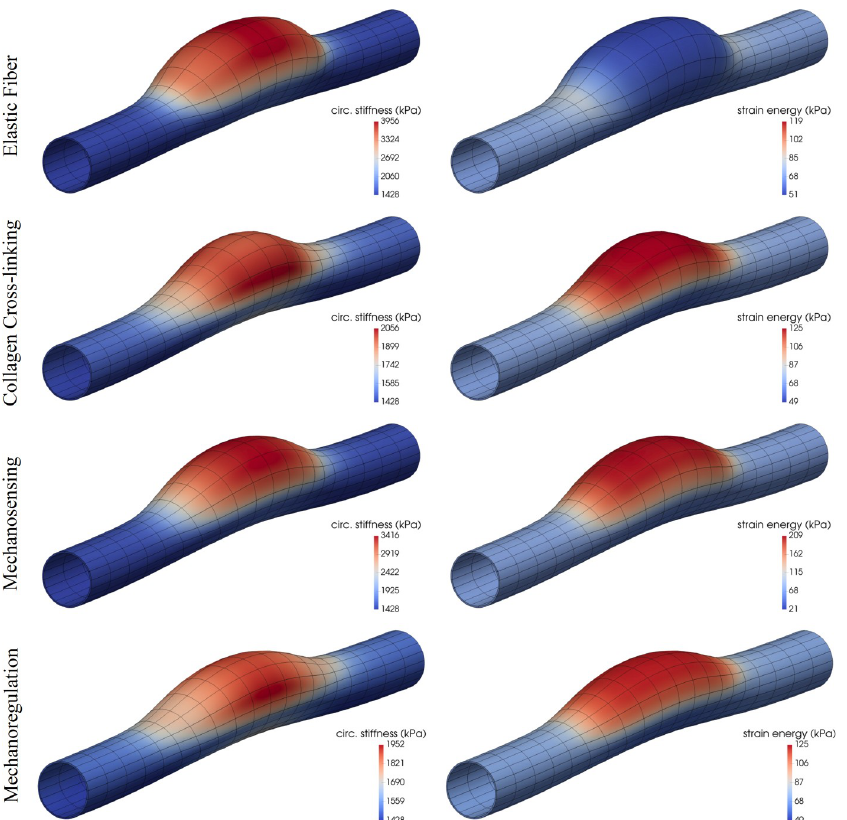
Fig 4. Fully developed, mechanobiologically equilibrated, asymmetric dilatations of an initially cylindrical aortic segment caused by marked locally compromised elastic fiber integrity (first row, 78% decrease in c e ), collagen cross- linking (second row, 53% decrease in c c ), mechanosensing (third row, δ = 0.4), or mechanoregulation (fourth row, 1 in Eq (10). Shown are color maps for circumferential material stiffness (left) and elastic 2.3% decrease in G c ) via ϑ apex energy storage per unit current volume (right) for the mechanically-loaded geometries. Note the original in vivo homeostatic values c = 1428 kPa (dark blue, bottom mark) and W = 68 kPa (light blue, second-from-bottom θθθθo o mark). Both K a = K a j > 0 and η end < 1 were adjusted via Eq (9) to maintain the distal and proximal segments normal t w s end (cf. Figs A and F in S1 Supporting